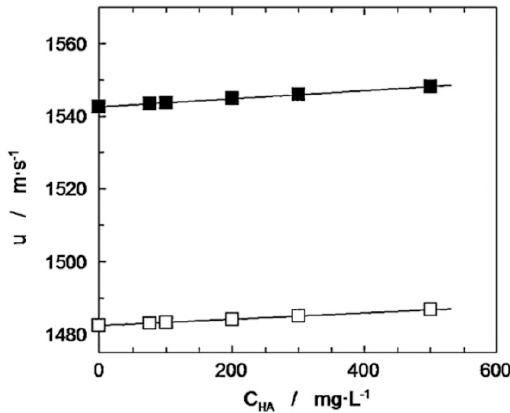
Figure 15. Dependence of ultrasound velocity on hyaluronic acid concentration and temperature: ( □ ) T = 20 °C, ( ■ ) T = 50 °C. Adapted from [76], with permission from Elsevier. 2020.